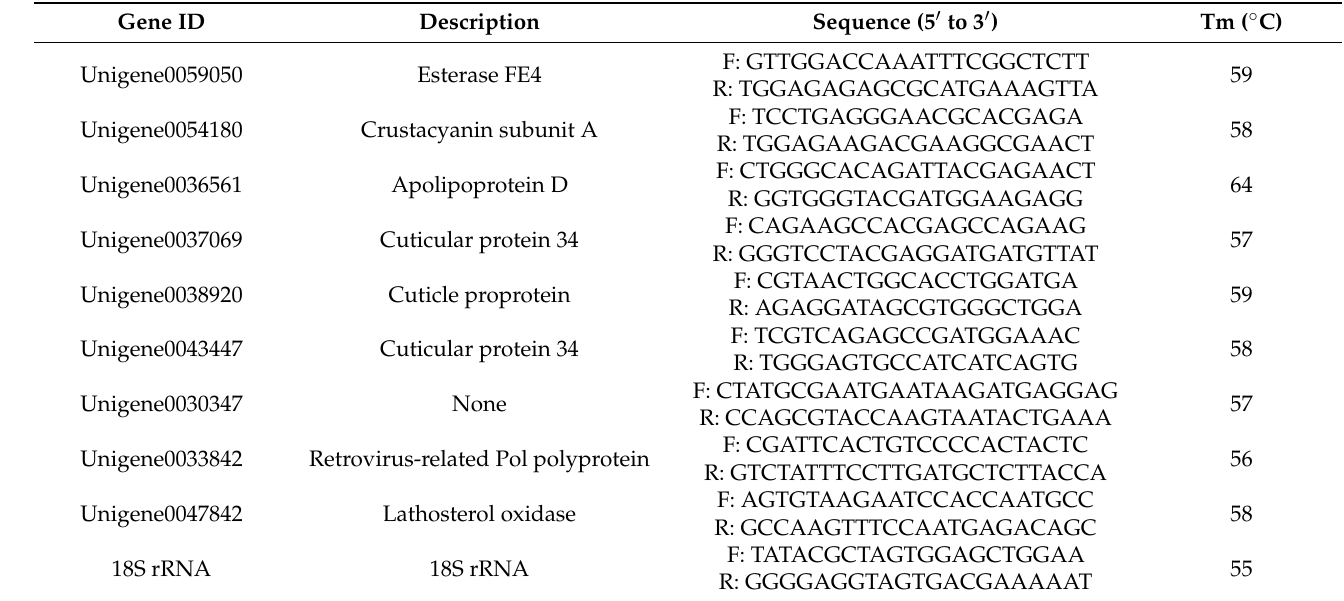
Table 1. Information of primers used for real-time PCR.